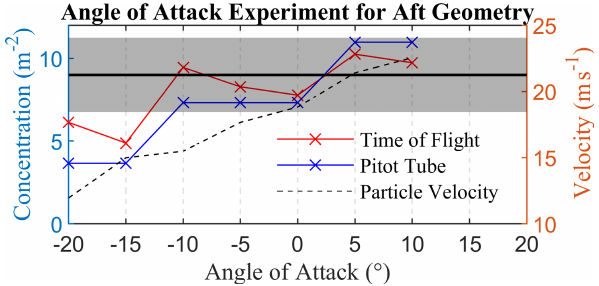
Figure 5. Calculated droplet concentration against AoA for CFD- LPT simulated data. The solid black line shows the input concentra- tion, and the black shaded region around it represents ± 25% of the input. The red and blue lines are the concentration data calculated using simulation equivalent droplet ToF and pitot tube airspeed, re- spectively. The black dotted line is the mean velocity of a droplet as its simulated trajectory crossed the UCASS sample